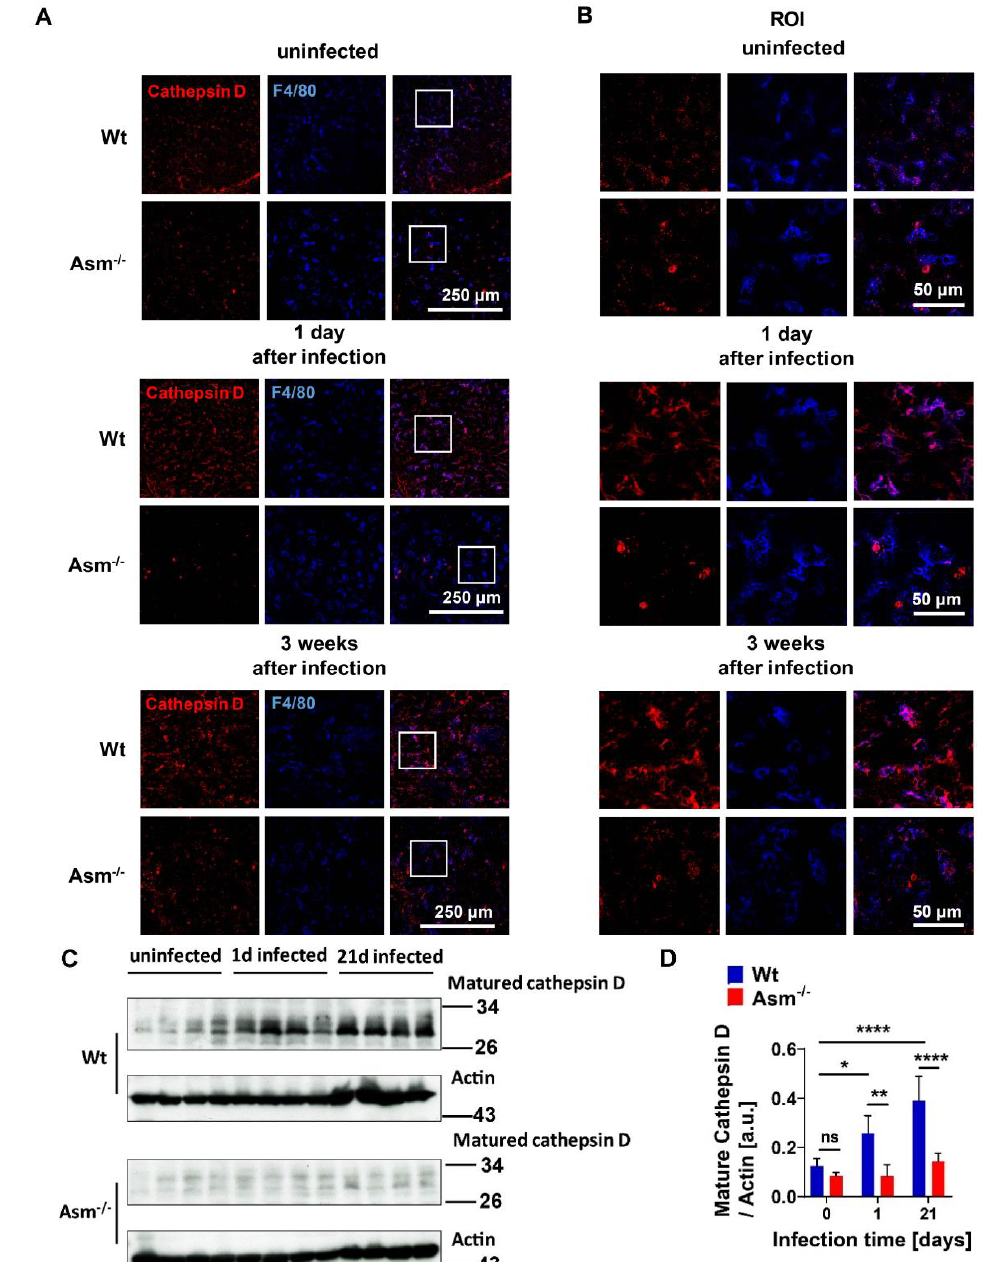
Figure 6. Cathepsin D upregulation upon BCG infection depends on acid sphingomyelinase expression in vivo. Wild-type (wt) and acid-sphingomyelinase-deficient (Asm −/− ) mice were intravenously infected with 10 7 BCG for 1 day (1d) or 3 weeks (3w) or left uninfected. ( A – D ) Cryosections from liver tissues were fixed and stained with antibodies against mature cathepsin D (CTSD) and corresponding Cy3-coupled secondary antibodies, APC-conjugated F4/80 antibodies, and analyzed by confocal microscopy with a 40× lens ( A ) or at higher resolution for areas of interest (ROI) ( B ). Shown are representative confocal fluorescence images from at least 3 independent experiments. Scale bar = 250 µm ( A ) or 50 µm ( B ). ( C ) CTSD expression from 4 mice/time point was visualized by Western blotting with antibodies against mature CTSD/actin. Shown are representative blots from 4 independent experiments. ( D ) CTSD expression was normalized to actin levels, and quantification of CTSD arbitrary units (a.u.) was performed by using ImageJ. Displayed are means ± SD of 4 experiments; p -values were calculated by ANOVA followed by Bonferroni’s multiple comparisons test, **** p < 0.0001, ** p < 0.01, * p < 0.05. ns = no